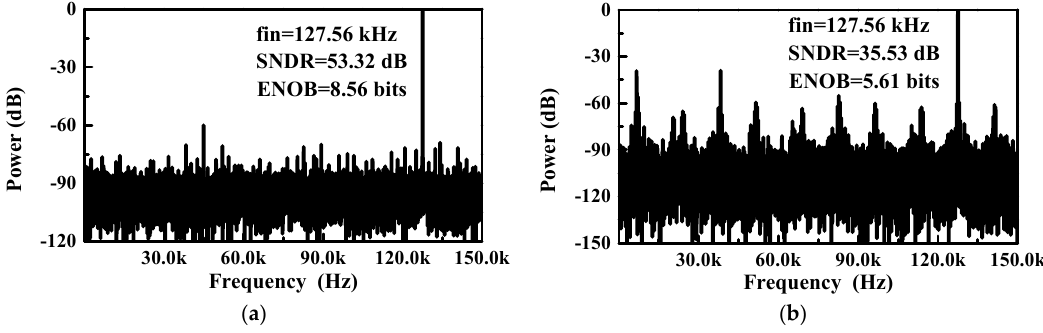
Figure 7. Measured output spectrum operating at 300 kS/s when a sinusoidal fluctuation of 50 mV pp and 134.2 kHz is added to the 0.8 V power supply of ( a ) proposed SAR ADC (i.e., Core1) and ( b ) conventional SAR ADC (i.e., Core2).